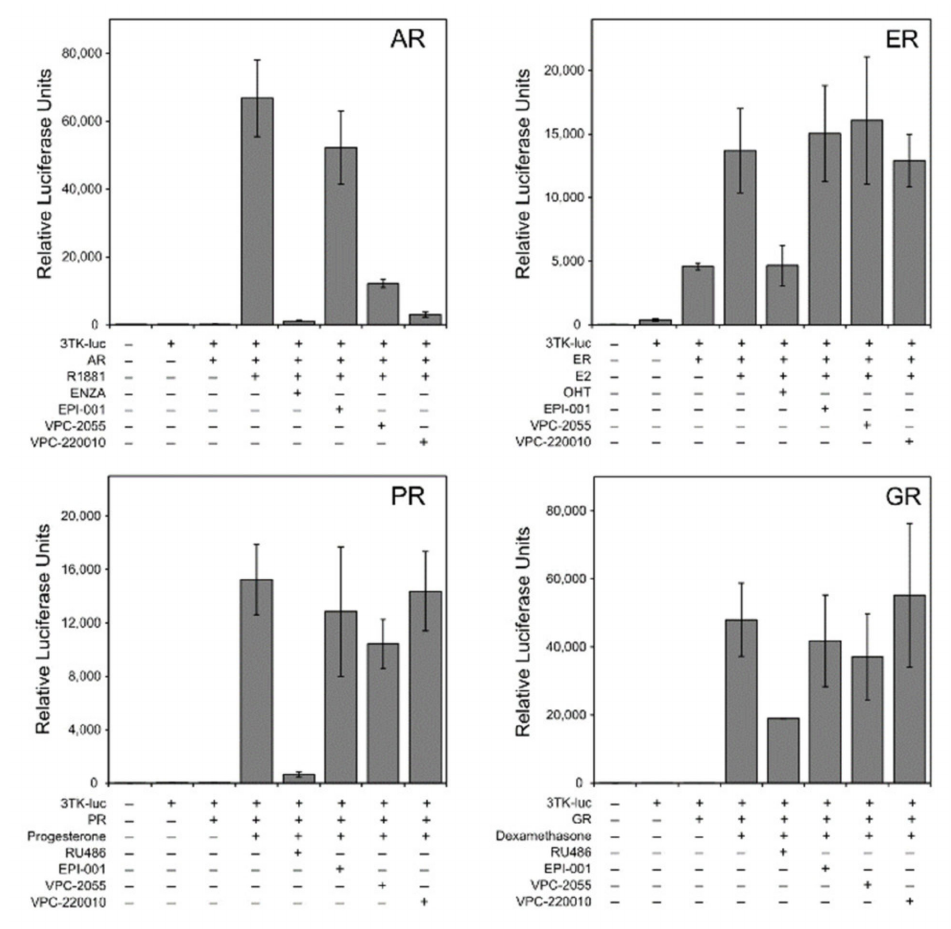
Figure 4. The selectivity inhibition profile of VPC-220010 against AR, ER, PR, and GR. Cells were transiently transfected with each nuclear receptor and suitable reporter plasmids before treatment with agonist and 20 uM of antagonists of EPI-001, VPC-2055, and